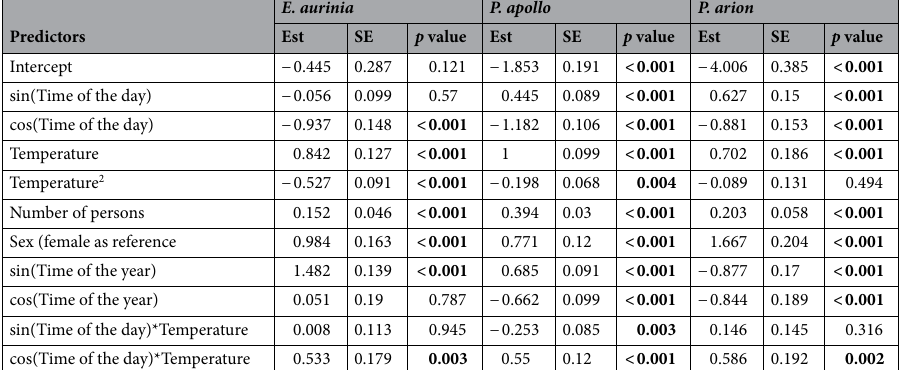
Table 1. Predictors of the number of individuals, models output for each species. Estimate, CI, and p values from a GLM with a negative binomial error structure. Significant values are in